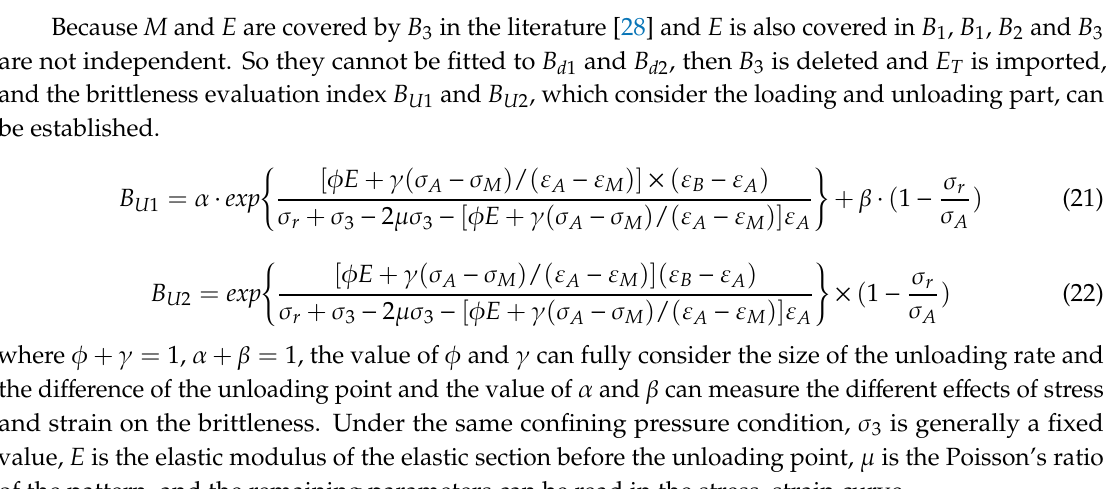
Table 7. Table of the brittleness indicator parameter.